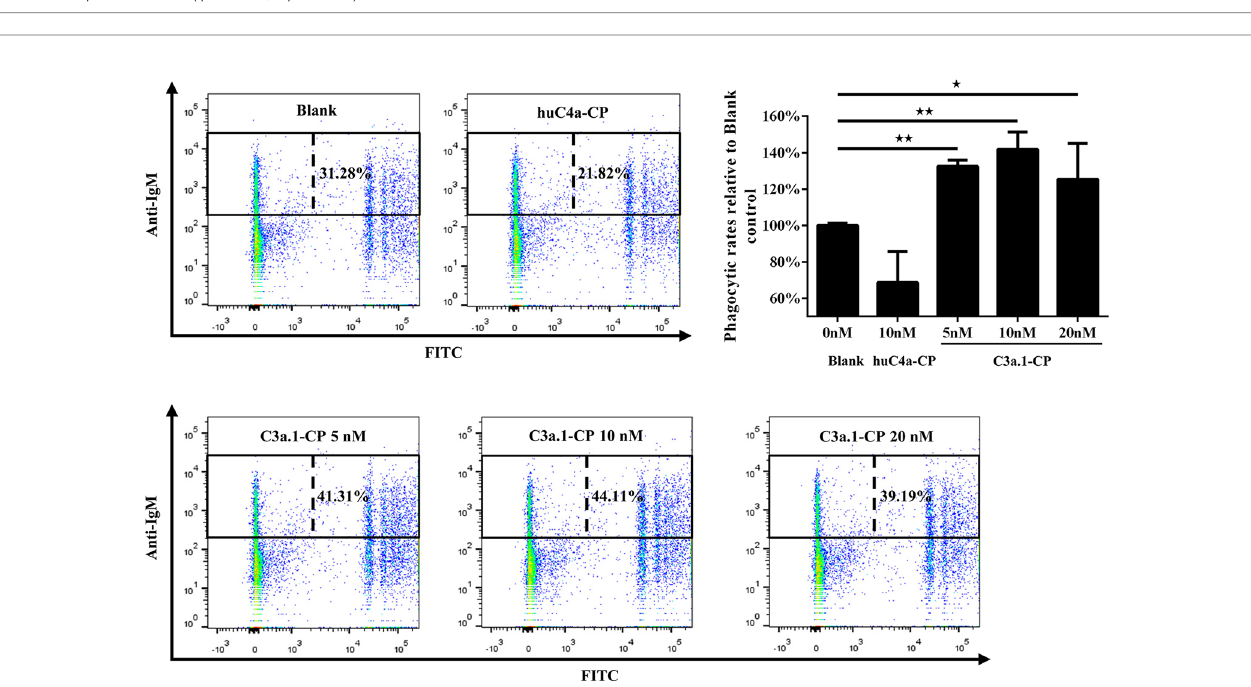
FIGURE 6 | The C-terminal a -helix peptide of C3a.1 (C3a.1-CP) enhances the phagocytic activity of grass carp IgM + B cells. HKLs were incubated with C3a.1-CP and fl uorescent beads at 28°C for 2 h. The PBS and C-terminal peptide of human C4a (huC4a-CP) were used as the blank and negative controls, respectively. After incubation, the non-ingested beads in cell suspensions were removed, and the cells were stained with mouse anti-grass carp IgM mAbs. Finally, the phagocytic activity of grass carp IgM + B cells was detected using fl ow cytometry. One representative result was shown in the dot plot of fl ow cytometry. Data are presented as mean ± SEM (n = 3 fi sh), and the statistic p value was calculated by one-way ANOVA with a Dunnett post hoc test (* p < 0.05, ** p <